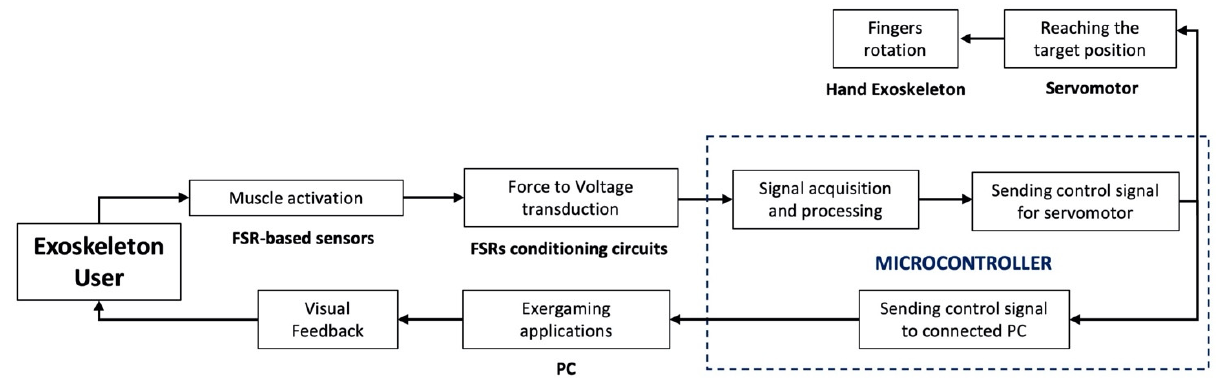
Figure 13. Flowchart describing exergaming applications with the use of the hand exoskeleton.